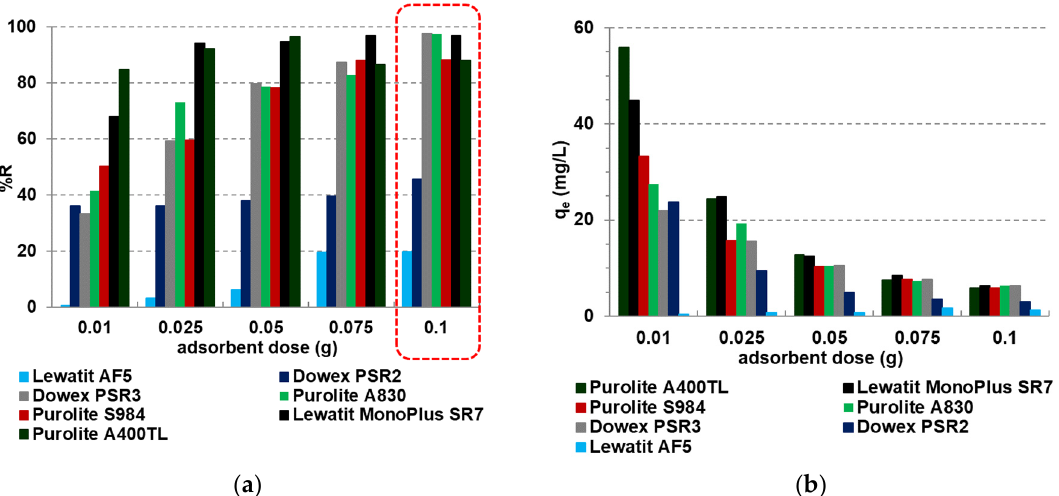
Figure 5. Effects of sorbent mass on ( a ) the percentage removal ( %R ), ( b ) sorption capacity ( q e ) values obtained during the V(V) sorption on the sorbents under discussion.